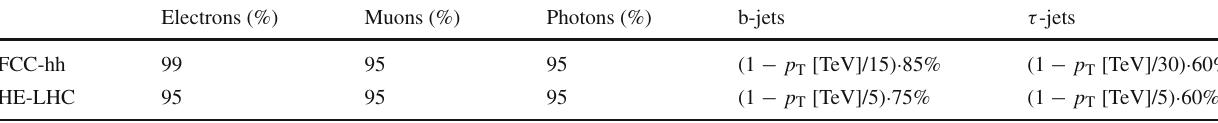
Table 3 Global reconstruction efficiency of high p T central objects for the HE-LHC and FCC-hh detectors in